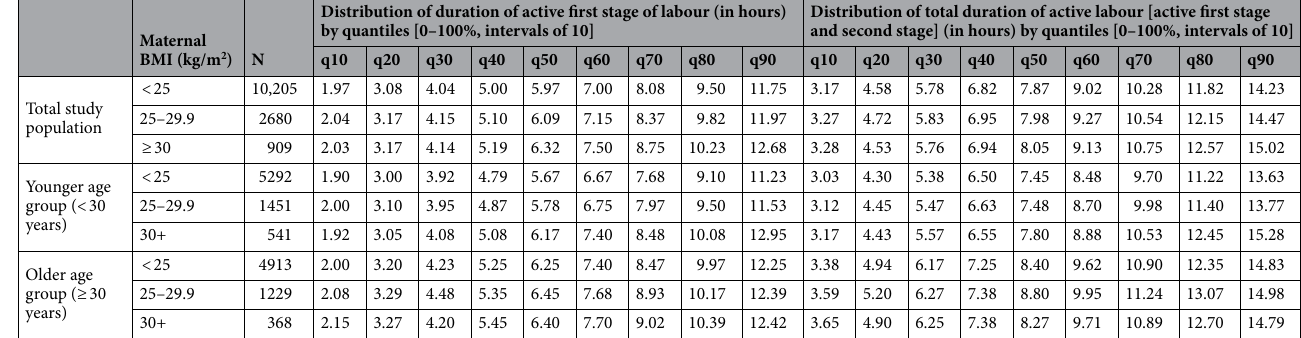
Table 2. Distribution of active phase and totallabour duration in each of three BMI-categories, in the total study population and stratified by age groups (< 30 vs ≥ 30).